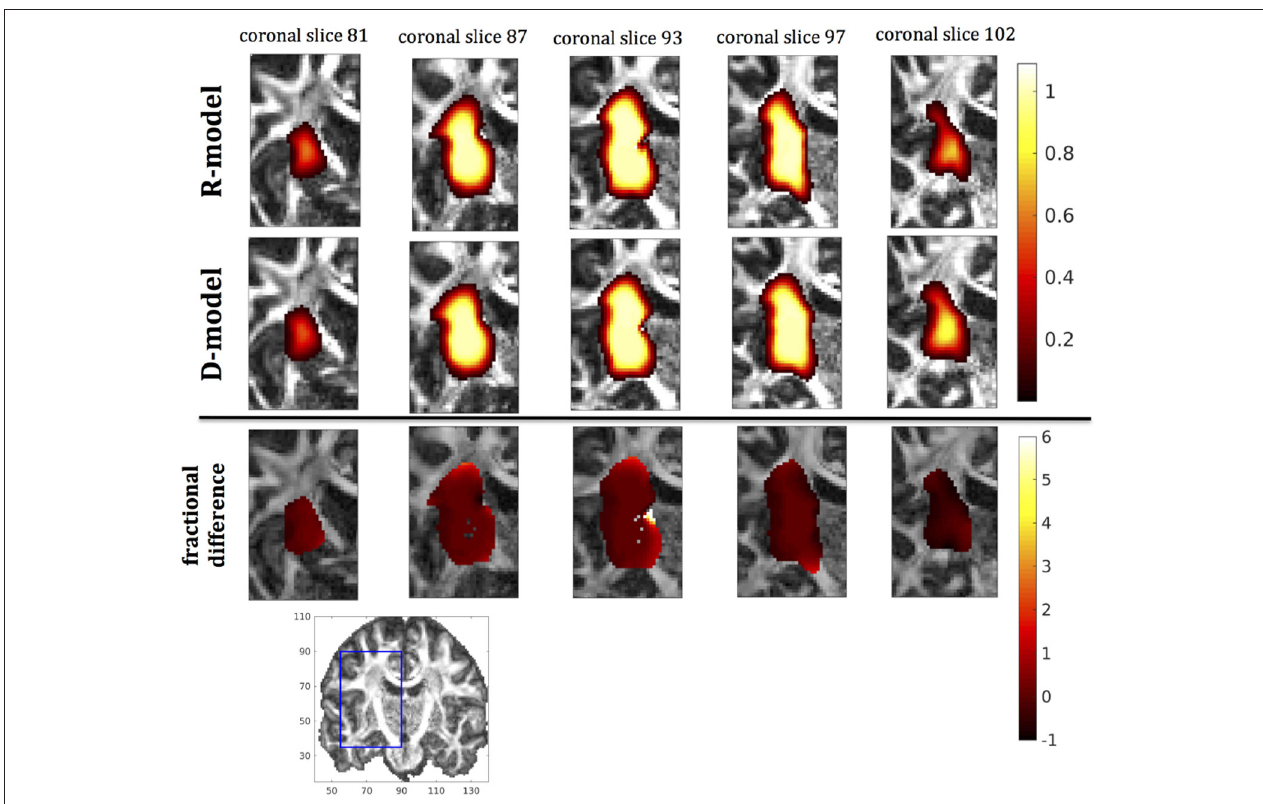
FIGURE 8 | Predicted concentrations for infusion in the internal capsule. (Top) R-model prediction for 5 coronal slices, (Middle) D-model prediction for the same ). The same scale has been used to plot the concentration distributions for the R- and the D- model. slices, (Bottom) fractional difference in concentrations ( C R − C D C D The FA image at the bottom shows in blue the part of the brain slices shown